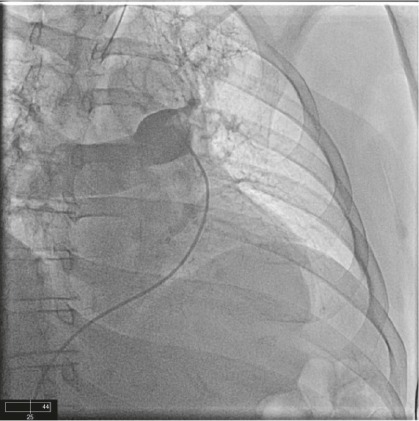
Figure2:Startofinjectionwithcontrastshowingmainlyintheright lung with some contrast in the left upper lobe.